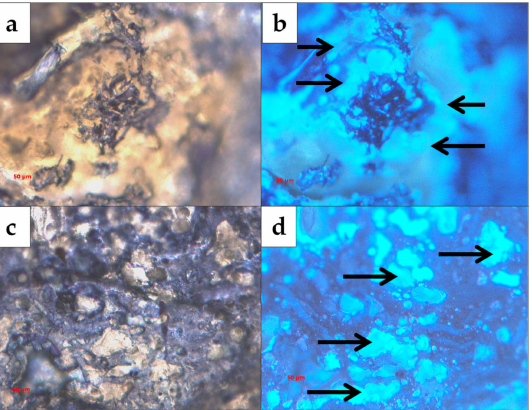
Figure 1. CS-reinforced with PCL ( a , c ) and stained with CW ( b , d ). Arrows show Ch. The SEM micrographs for CS, PCL, and MCP (Figure 2a–c) evidence that CS and